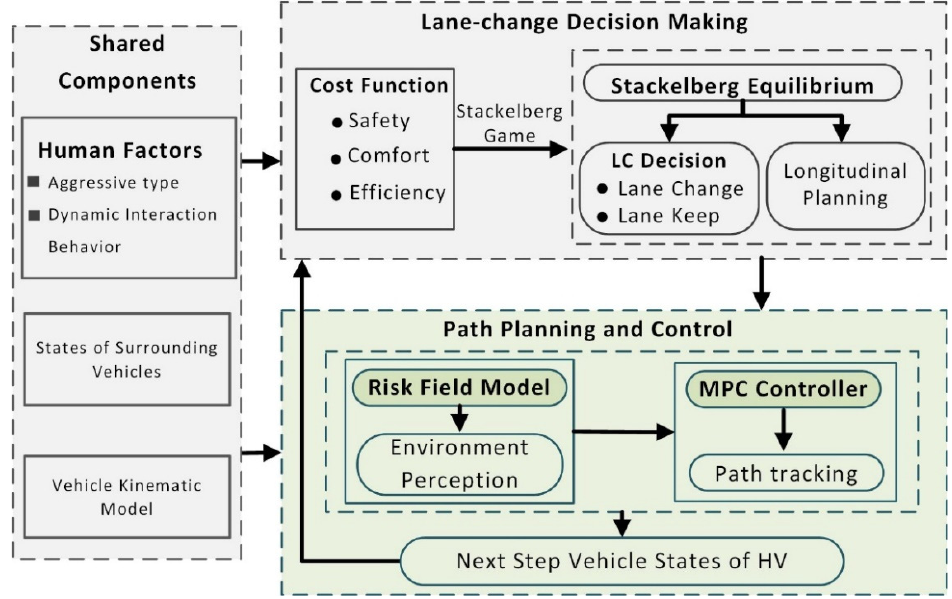
Figure 1. The lane-changing behavior decision-making framework for AVs.